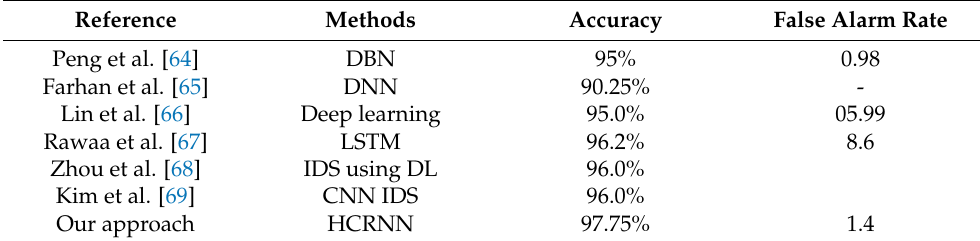
Table 6. Comparison of existing approaches with the CSE-CIC-IDS2018 data.